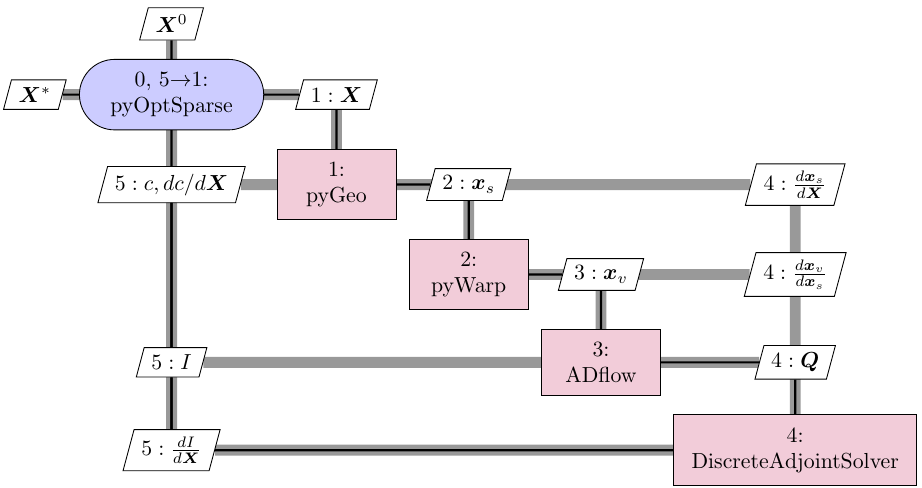
Figure 8. Design optimization